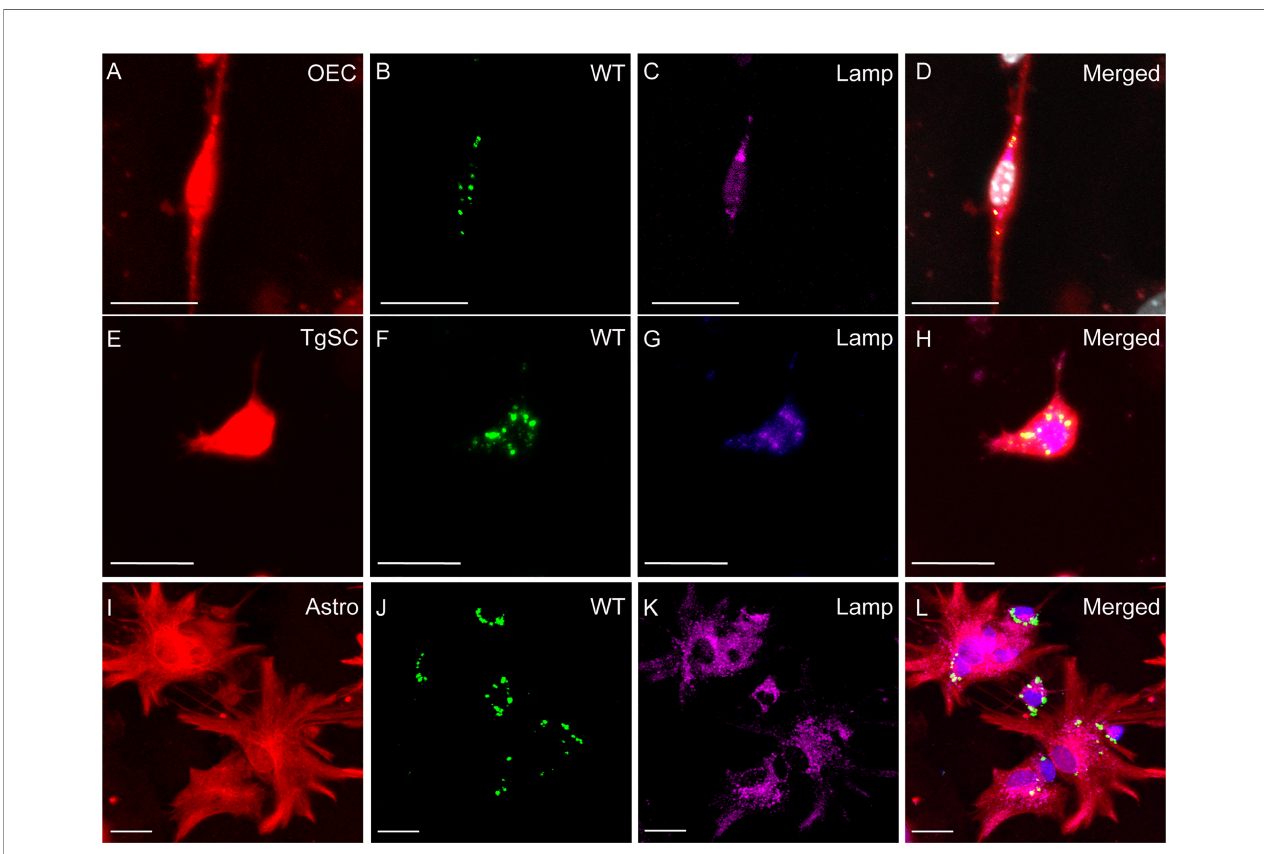
FIGURE 6 | Phagocytosis of S. agalactiae in phagolysosomes in glial cells (OECs, TgSCs and astrocytes) 24 h post infection. Panels show primary cultures of OECs (A – D) , TgSCs (E – H) and astrocytes (I – L) from S100 b -DsRed mice. OEC and TgSCs were visualised by DsRed expression (red), whilst astrocytes were immunolabelled for GFAP (red). Nuclei are stained with Hoechst. (B, F, J) shows S. agalactiae within cells, (C, G, K) LAMP-2 immunolabelling for lysosomes and (D, H, L) S. agalactiae colocalizes with LAMP-2 showing the bacteria is internalized in phagolysosomes. Scale bar: 25 m